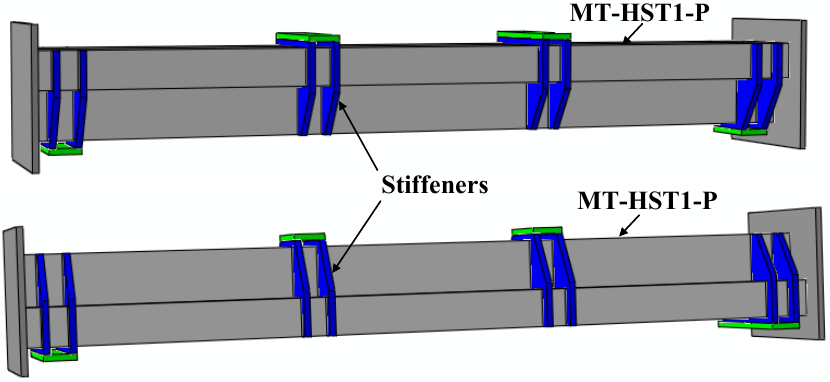
Figure 5. Cross-sections under different bending moments: ( a ) Positive bending moment; ( b ) negative bending moment.